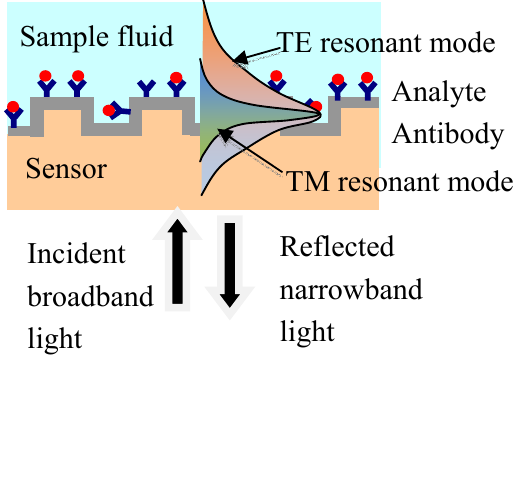
Figure 4. Schematic of a single channel in a label-free GMR sensor system operating in reflection mode. The collimated beam from a broadband source is incident on the sensor at normal incidence. The reflected spectral response is monitored in real time with an optical spectrum analyzer. As binding events occur at the sensor surface, resonance peak changes can be tracked. The resonance occurs at different wavelengths or angles for TE and TM polarization states of the input light, enabling high-accuracy